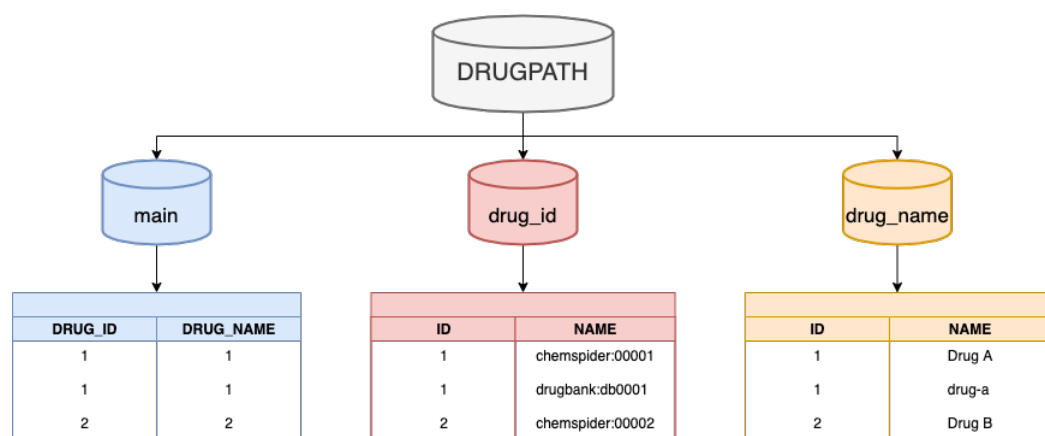
Figure 11. Structure of the DRUGPATH SQLite database, where main , drug_id , and drug_name are all separate tables within the file. Here, DRUG_ID “1” corresponds to multiple identifiers within the drug_id table for DRUG_NAME “1”, which in turn represents the various names of Drug A within the drug_name table. Note that within the main table, there are a total of 10 columns, but only the DRUG_ID and DRUG_NAME columns are shown in this